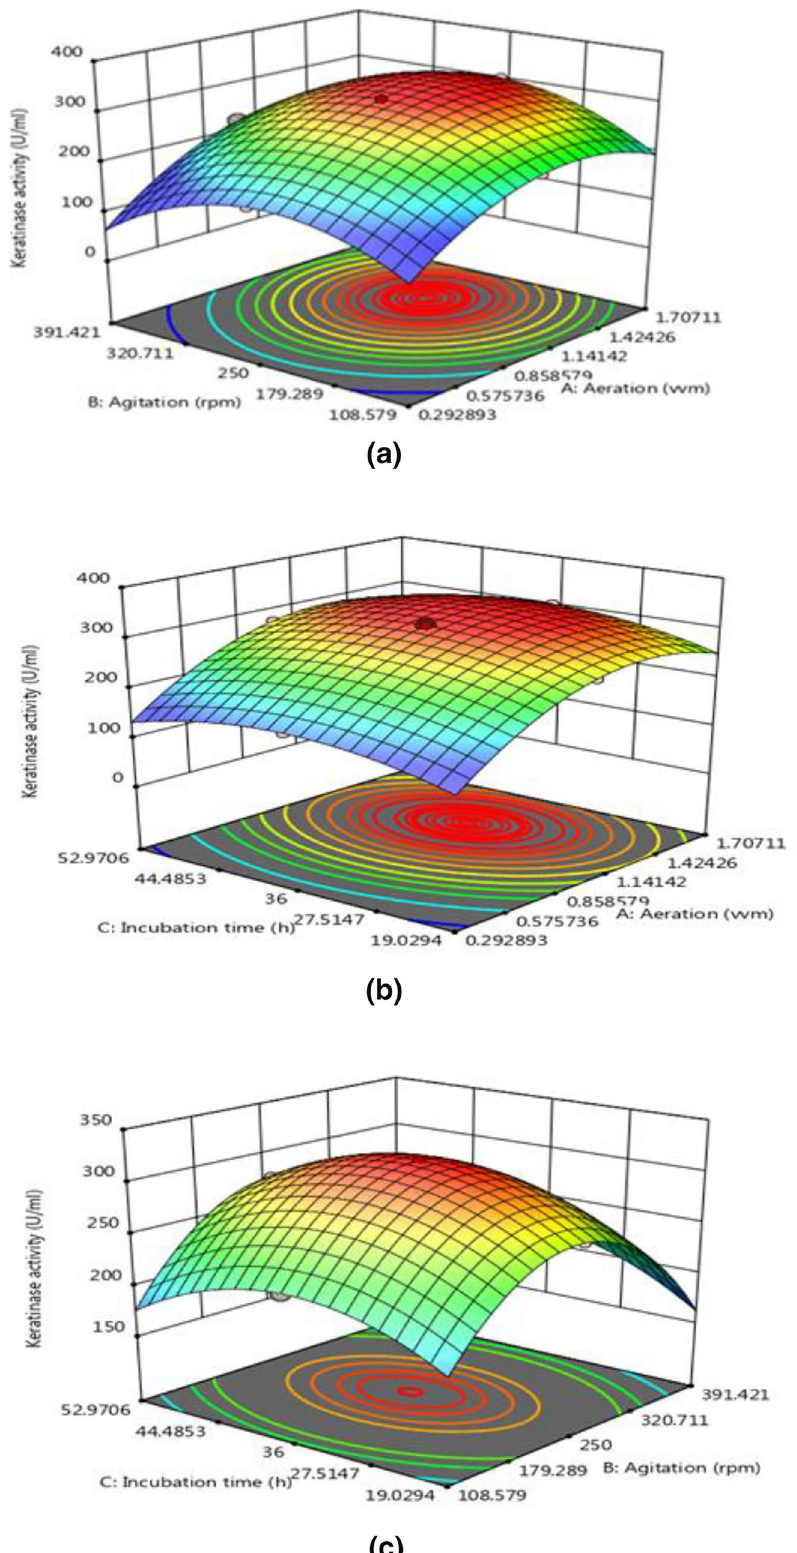
Fig. 2 3D response surface plots depicting the effect of a Agitation and aeration, b aera- tion and incubation time, and c incubation time and